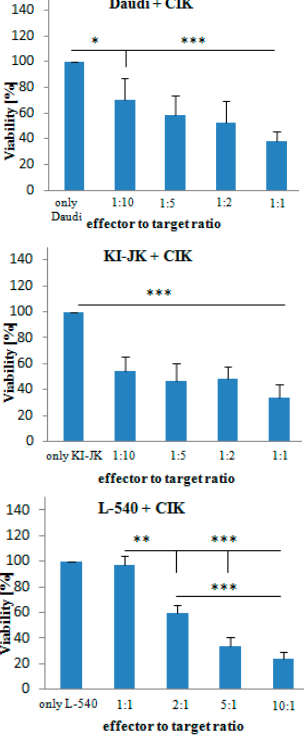
Figure 1. Cytotoxic effect of CIK cells on lymphoma cell lines Daudi , KI-JK and L-540 . The cells were cultured at various effector:target ratios of 1:10, 1:5, 1:2 and 1:1 ( Daudi. and KI-JK ), and 1:1, 2:1, 5:1 and 10:1 ( L-540 ) for 24 h. Subsequently, cell viability was measured using an MTT assay. Results represent data from three different buffy coats. For each probe triplicates were used. Data are presented as mean ˘ SD ( p < 0.05). One asterisk indicates a p -value of 0.04 to 0.05, two asterisks indicate a p- value of 0.02 to 0.03 and three asterisks a p- value of